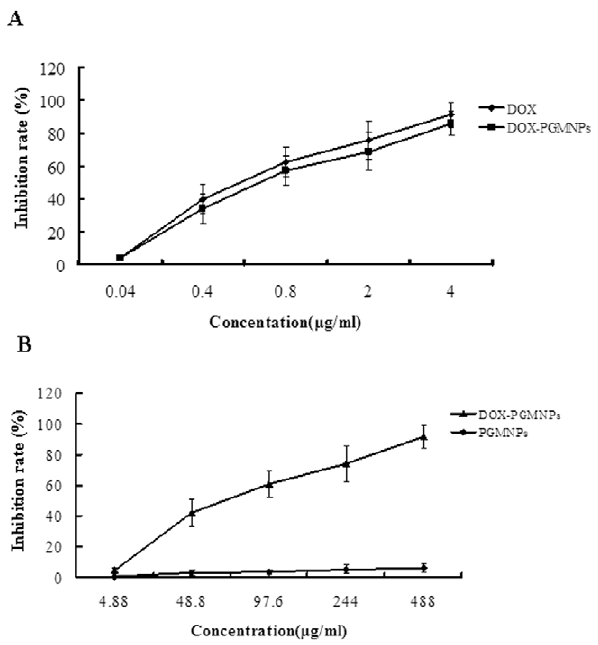
Figure 2. Cytotoxicity profiles of PGMNPs, DOX and DOX- PGMNPs upon H22 cell lines upon H22 cell lines determined by MTT assay. ( A ) H22 cells suspension were treated by DOX or DOX- PGMNPs conjugate. ( B ) H22 cells suspension were treated by PGMNPs or DOX-PGMNPs conjugate.